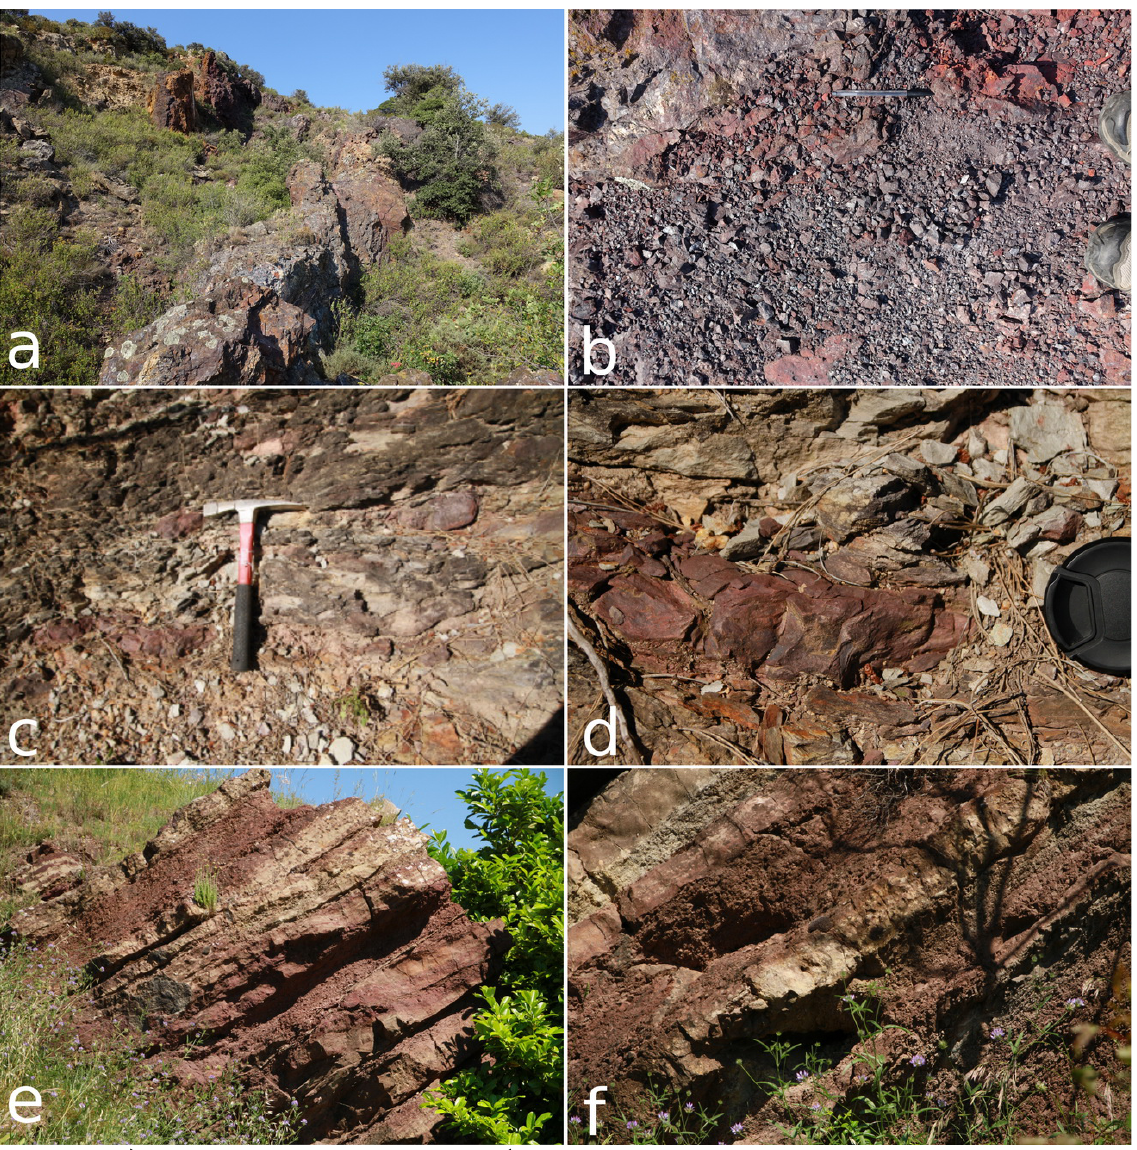
Figure 3. a-b) Hematite-quartz hydrothermal vein (contact between Upper Trias marl-gypsum and various Lower Jurassic carbonate formations), Lesquerde, Pyrénées-orientales, France, a) the metallic body measures around 500 m long, c-d) Hematite hydrothermal vein in arkosic sandstone (Trias), Bordezac, Gard, France, e-f) Stratiform hematite vein and metasomatism in Callovian limestone, Pierremorte, Gard, France, e) 3 m high. Photos: H.